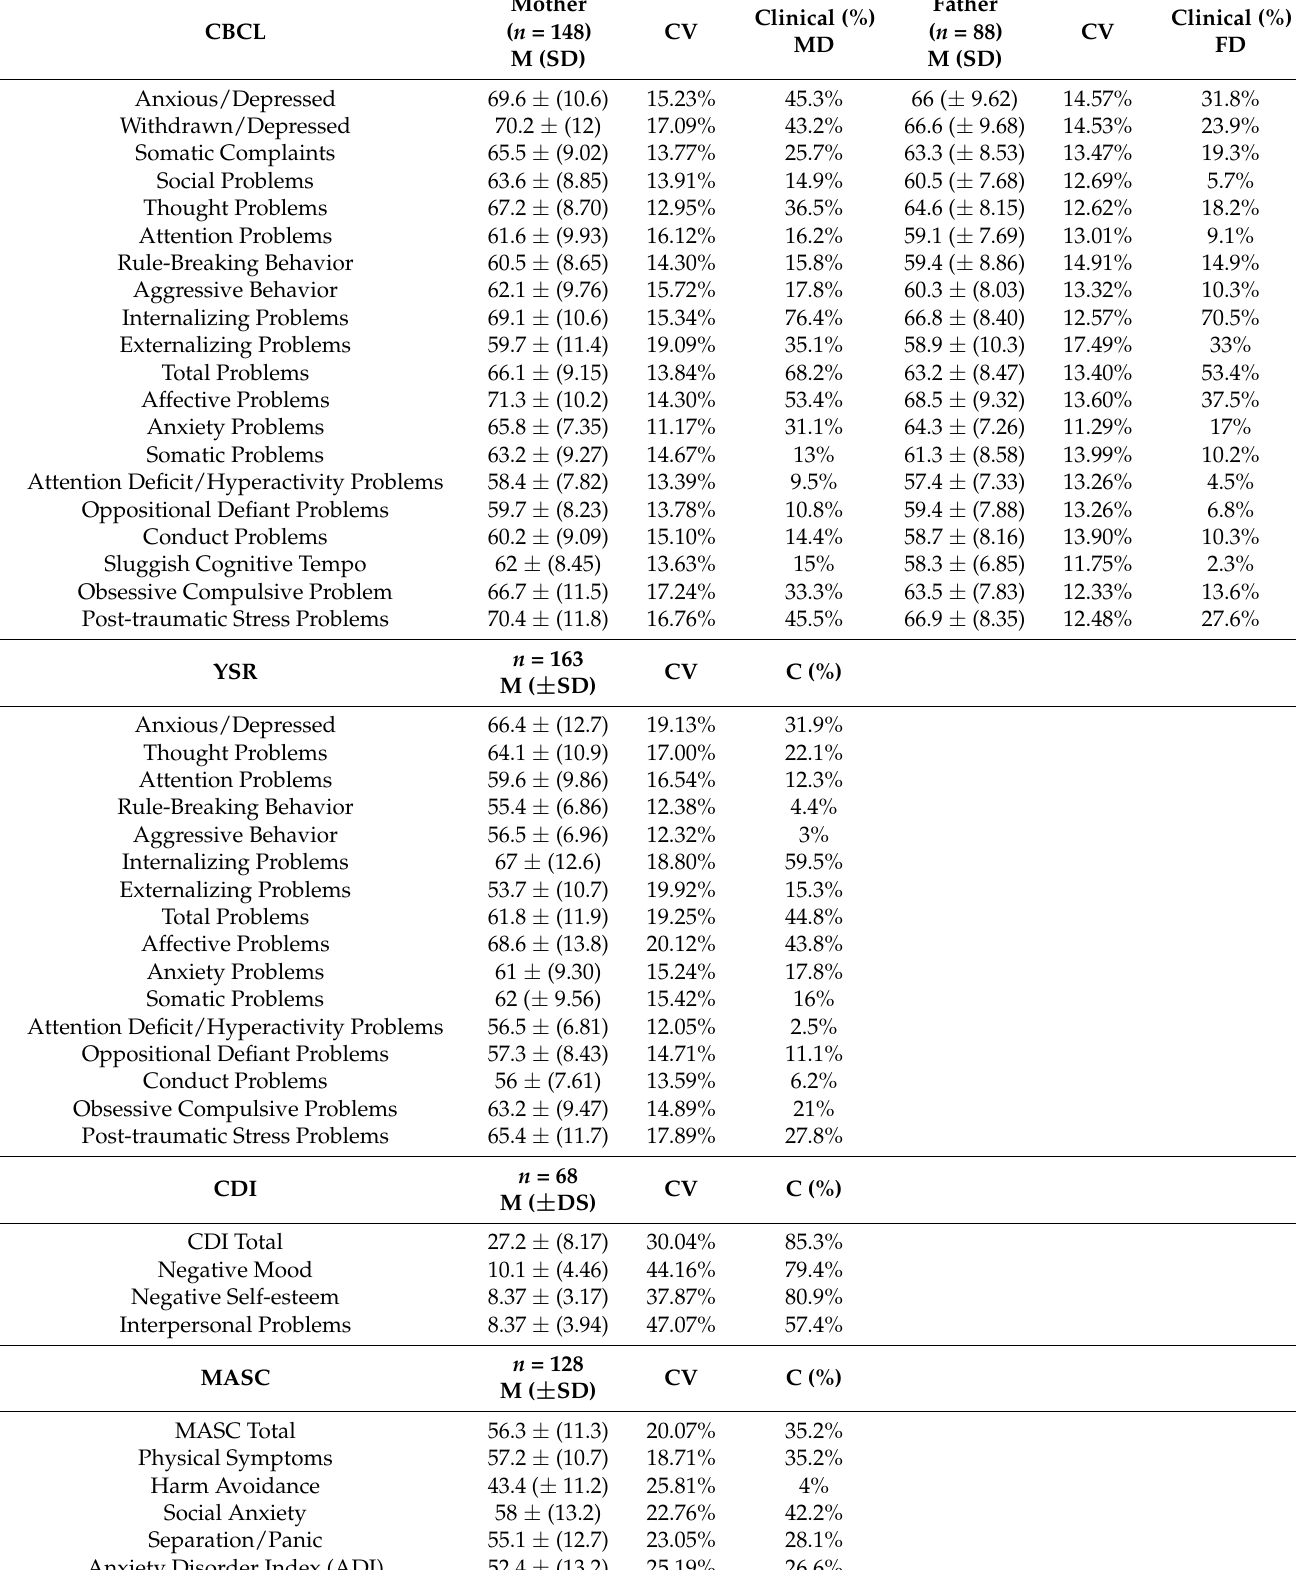
Table 2. Descriptive statistics (M; SD; Clinical %) for CBCL, YSR, MASC, and CDI